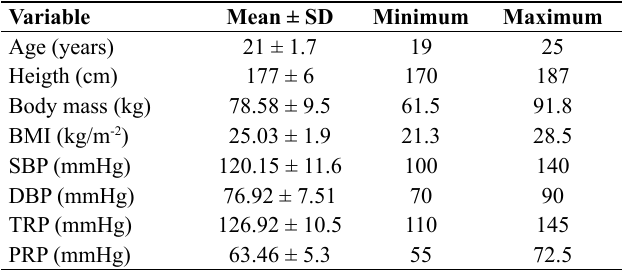
Table 1. Characteristics of the participants (n=13). Values are mean ± standard deviation, minimum and